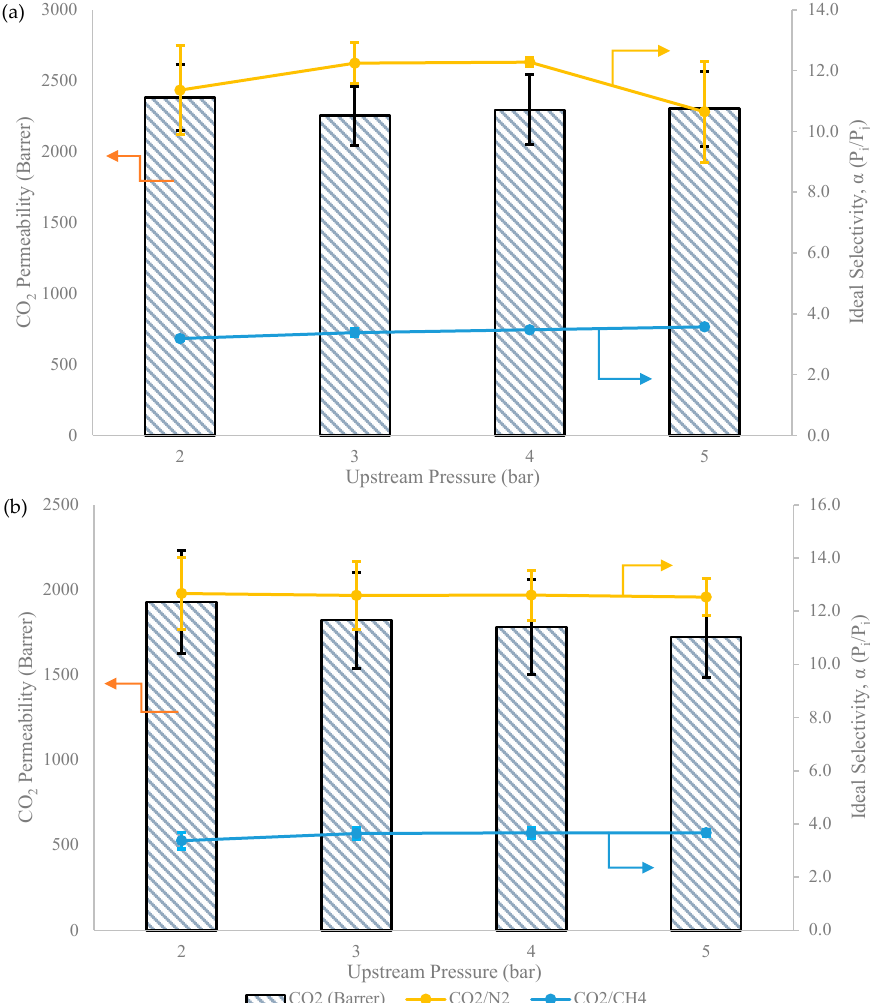
Figure 8. Gas separation performance of ( a ) M1 and ( b ) M4 at various pressures ranging from 2 to 5 bar at room temperature (T = 25 °C). Table 2. Gas performance comparison of PDMS MMM with other studies.